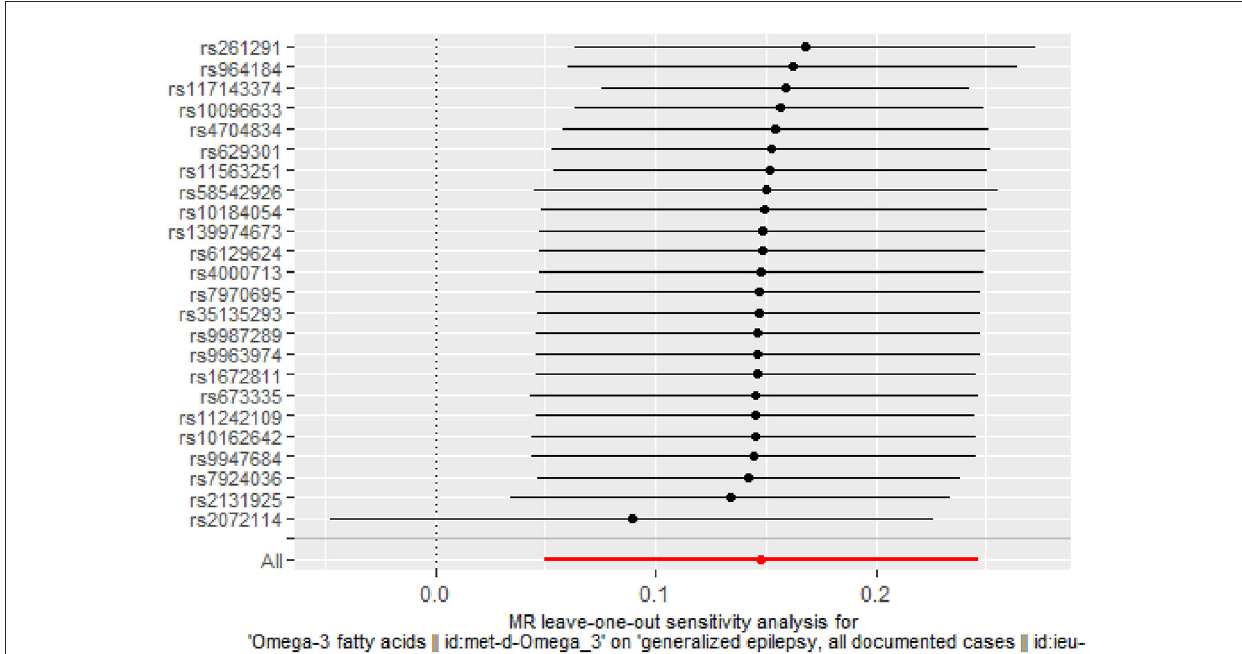
FIGURE4 Stability of the causal relationship between omega-3 fatty acids and generalized epilepsy assessed by leave-one-out sensitivity analysis. The x-axis shows the MR leave-one-out sensitivity analysis of omega-3 fatty acids on generalized epilepsy. The y -axis shows the analysis of the effect of removing individual SNP on generalized epilepsy.